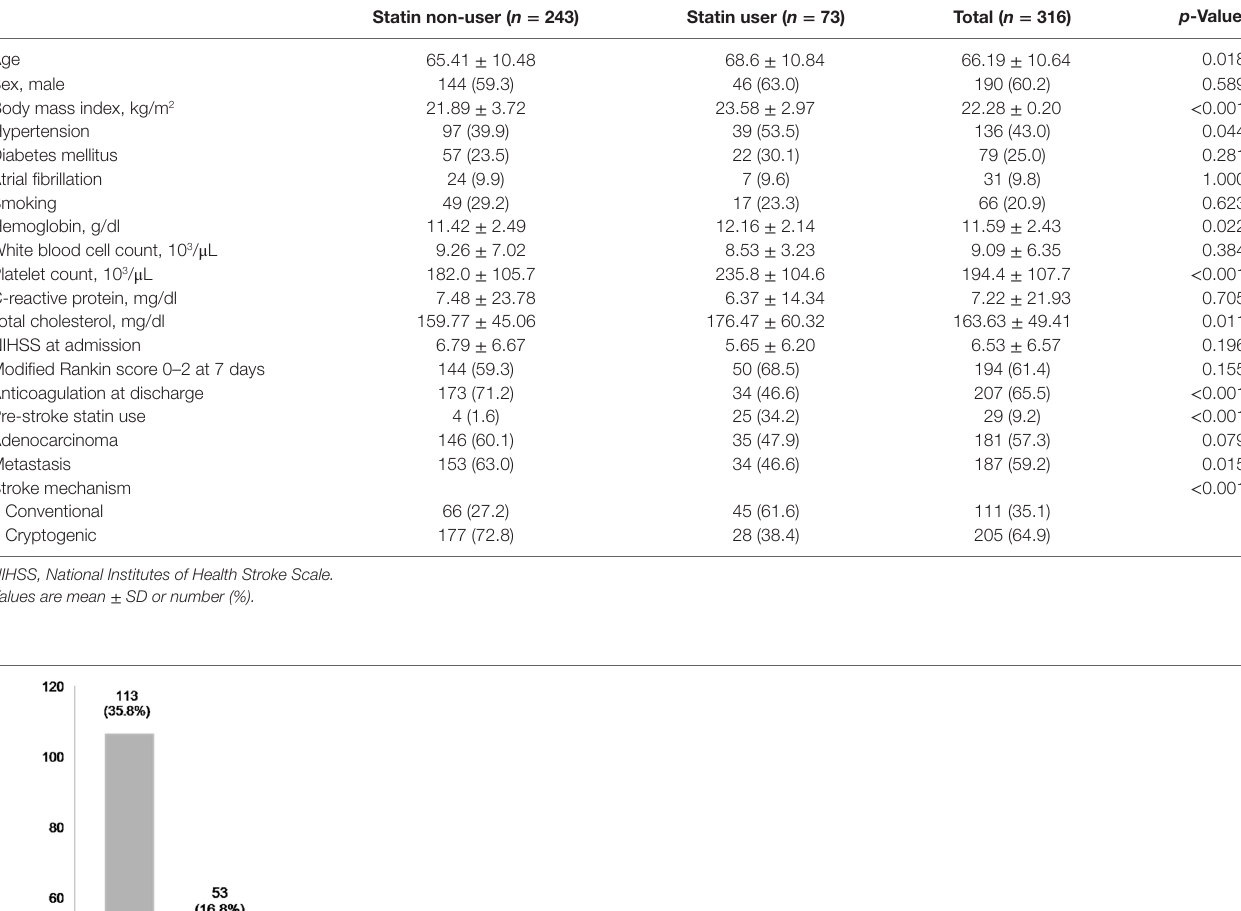
TaBle 1 | Baseline characteristics of the subjects categorized according to statin